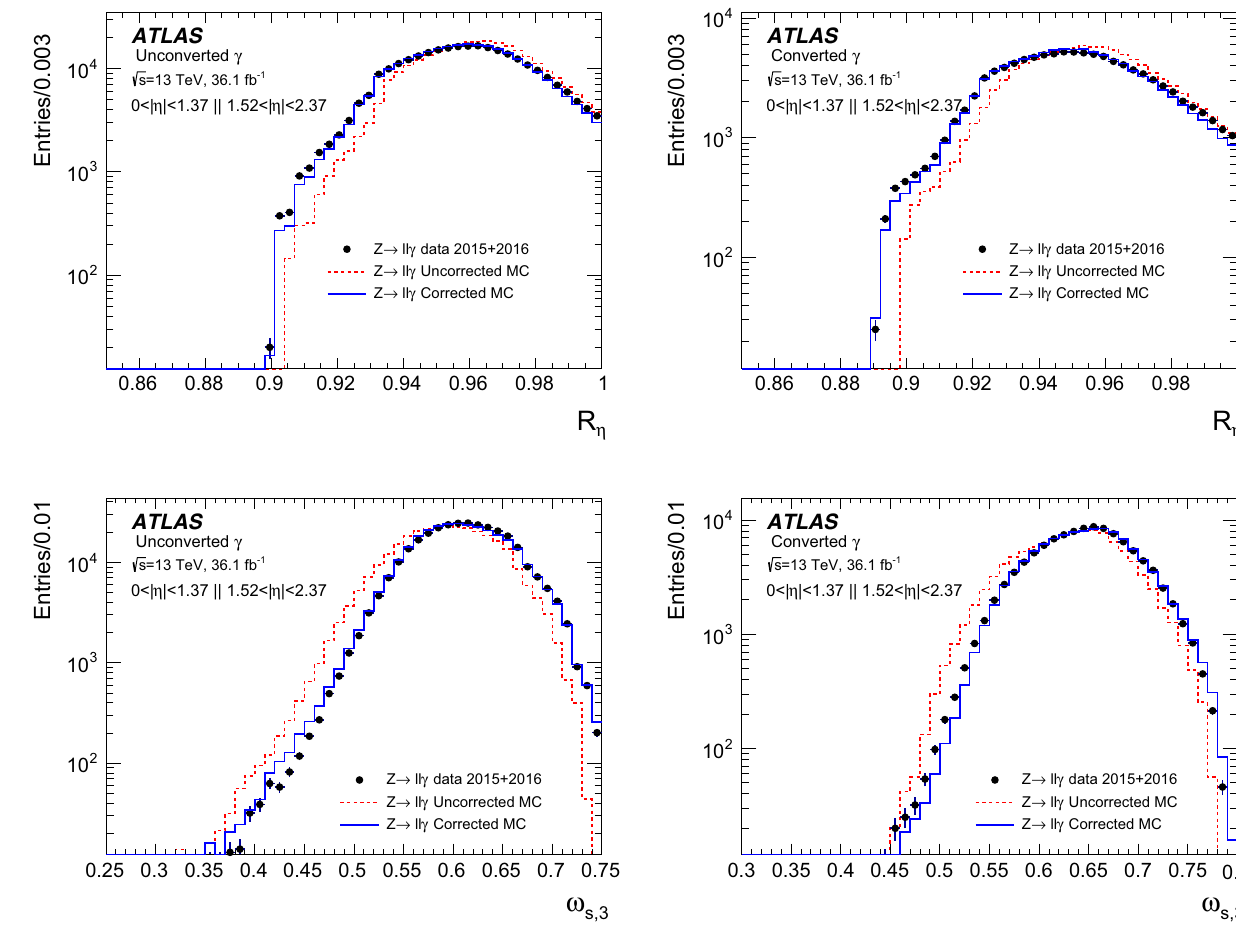
simulated Z → (cid:4)(cid:4)γ events are also shown. for the uncorrected sim- ulation (dashed red line) and the simulation corrected by the average shift between data and simulation distributions (solid blue line). The definition of the plotted variables is given in Table 1 and Fig.